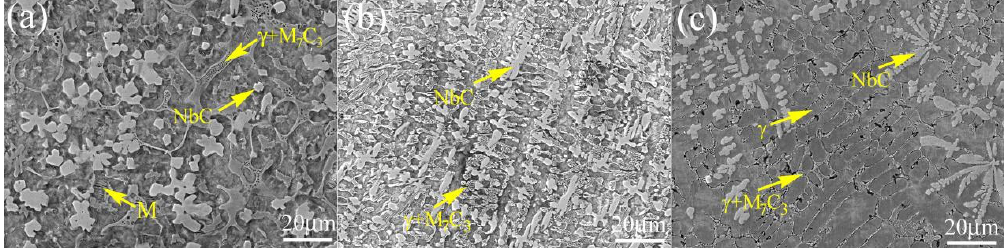
Figure 4. SEM images of the surface of the coatings with ( a ) 10.75% Nb-hypereutectic, ( b ) 11.65% Nb-near eutectic ( c ) 12.55%Nb-hypoeutectic.